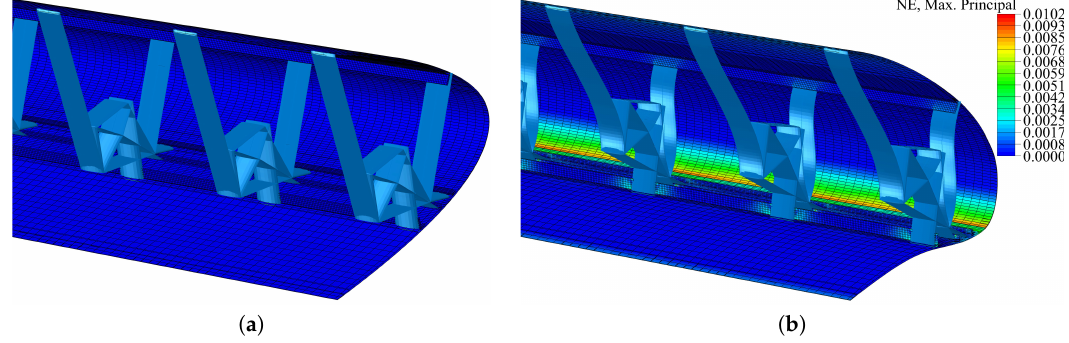
Figure 21. Flexible skin deformation level along the undeformed ( a ) and the actuated ( b )